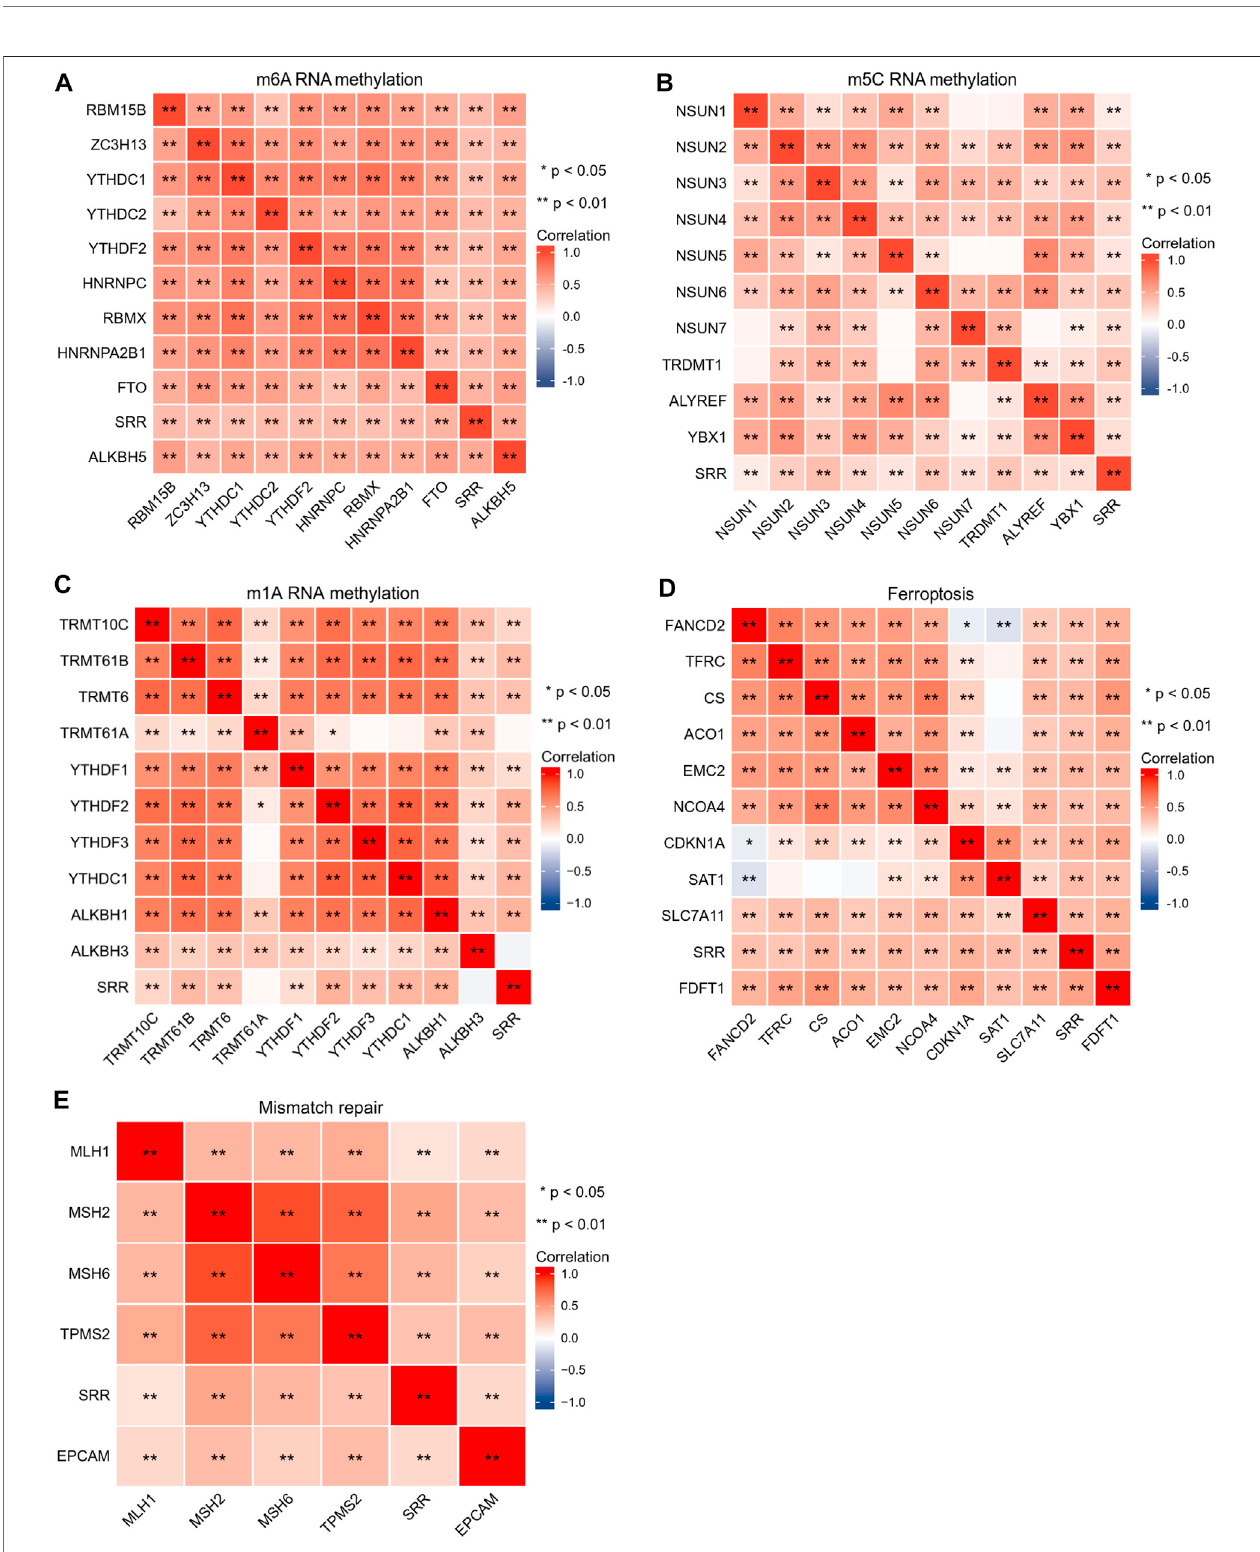
FIGURE 6 | Correlation analysis of SRR with m6A RNA methylation-related genes (A) , m5C RNA methylation-related genes (B) , m1A RNA methylation-related genes (C) , ferroptosis-related genes (D) , and mismatch repair-related genes (E) in UCEC. Red shows positive correlation, and blue shows negative correlation. The stronger the correlation, the darker the color. * p < 0.05, ** p < 0.01.